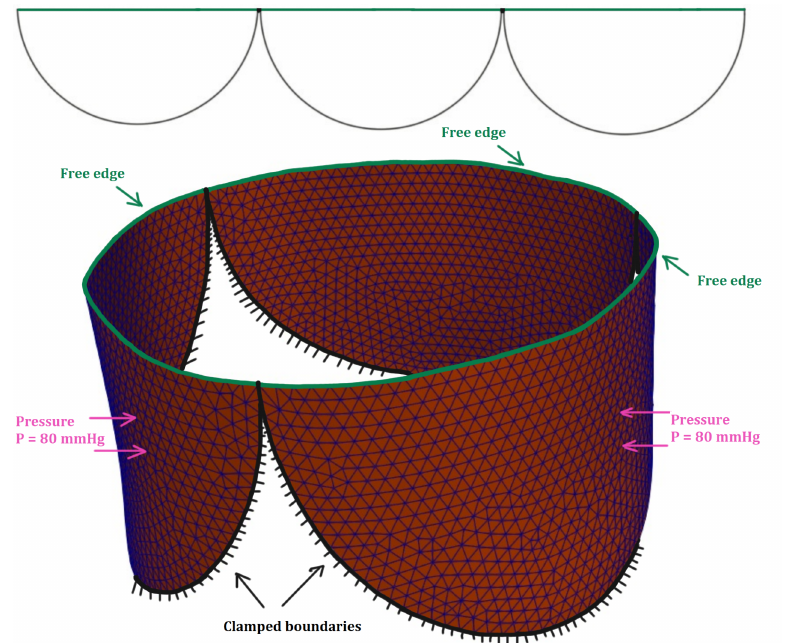
Figure 8. Schematic representation of the idealized aortic valve in the initial configuration, the boundary conditions and the computational mesh (mesh size h 1